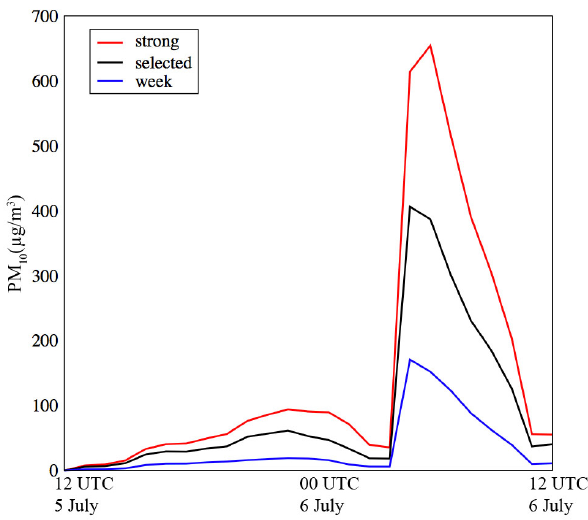
Fig. 10. NMME–DREAM PM 10 surface dust concentration in Phoenix for different masks of potential dust